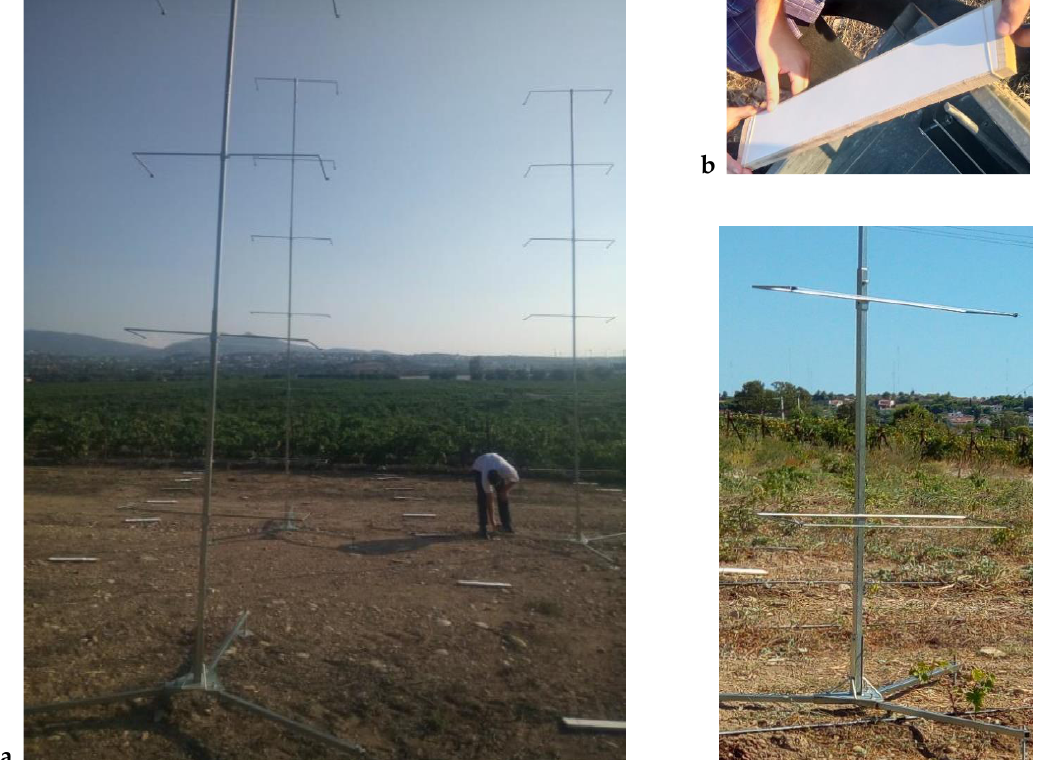
Figure 2. ( a ) The vineyard and sampling area; ( b ) detail showing the ground collector; ( c ) detail showing the pole holding the polythene lines.